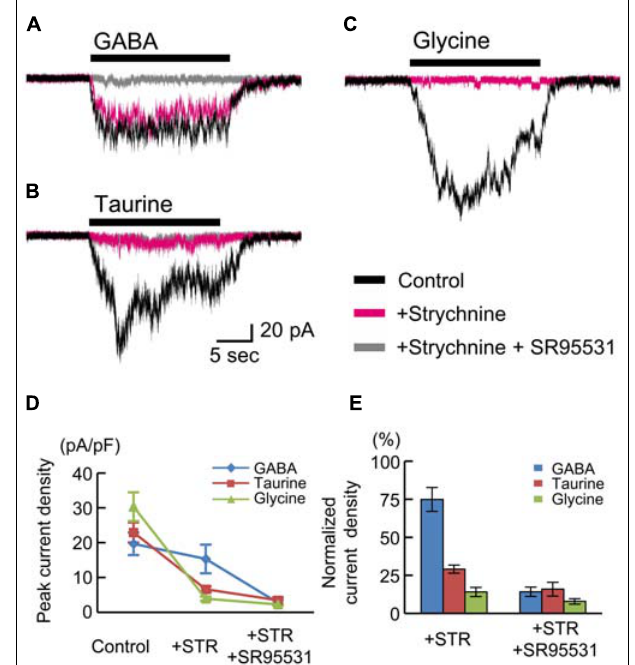
FIGURE 6 | GABA-, taurine-, and glycine-evoked currents in RFP-positive cells in rat fetuses at E18.5. Typical traces of the currents evoked by the application of 10 μ M GABA (A) , 10 mM taurine (B) , and 3 mM glycine (C) in RFP-positive cells are shown. Black traces indicate the currents in the absence of blockers; red traces are the currents obtained after the application of 10 μ M strychnine through bath perfusion in the same cells; and gray traces are the currents recorded after the further addition of 10 μ M SR95531 to the bath solution. V H was − 60 mV. (D) The means ± SEMs of the peak current densities in the absence and presence of strychnine (STR) and after the addition of SR95531 are plotted. (E) Effects of blockers on agonist-evoked currents.The peak current densities in the absence of blockers were normalized to